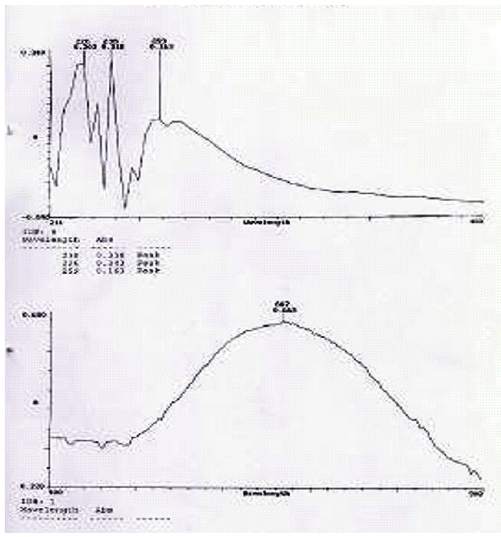
Figure 4: UV-Vis spectrum for Na 2 [Cu(asp) 2 ].